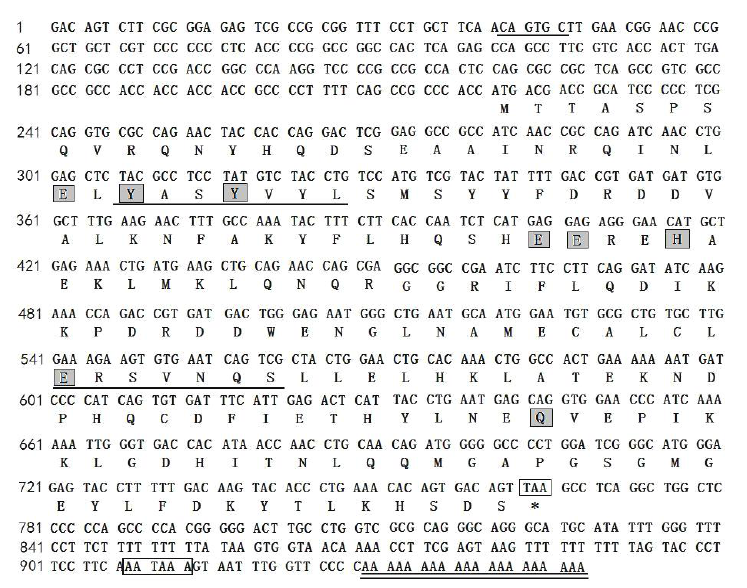
Figure 5. Nucleotide and deduced amino acid sequences of Panthera tigri s ferritin subunit (GenBank accession No.GQ891094). Seven boxed residues represented a tentatively active site of ferroxidase. The polyadenylation signal was in bold and the poly (A) tail was underlined. Iron associated residue (Try30) was in shaded